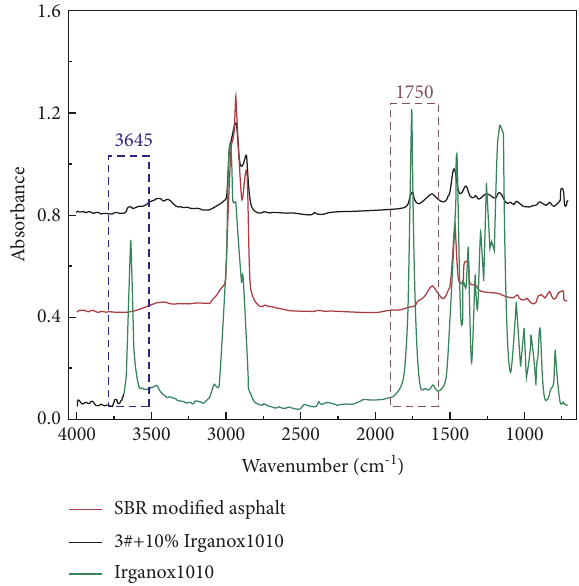
Figure 10: Spectra of Irganox 1010, SBR-modified asphalt, and 3#+ 10%Irganox